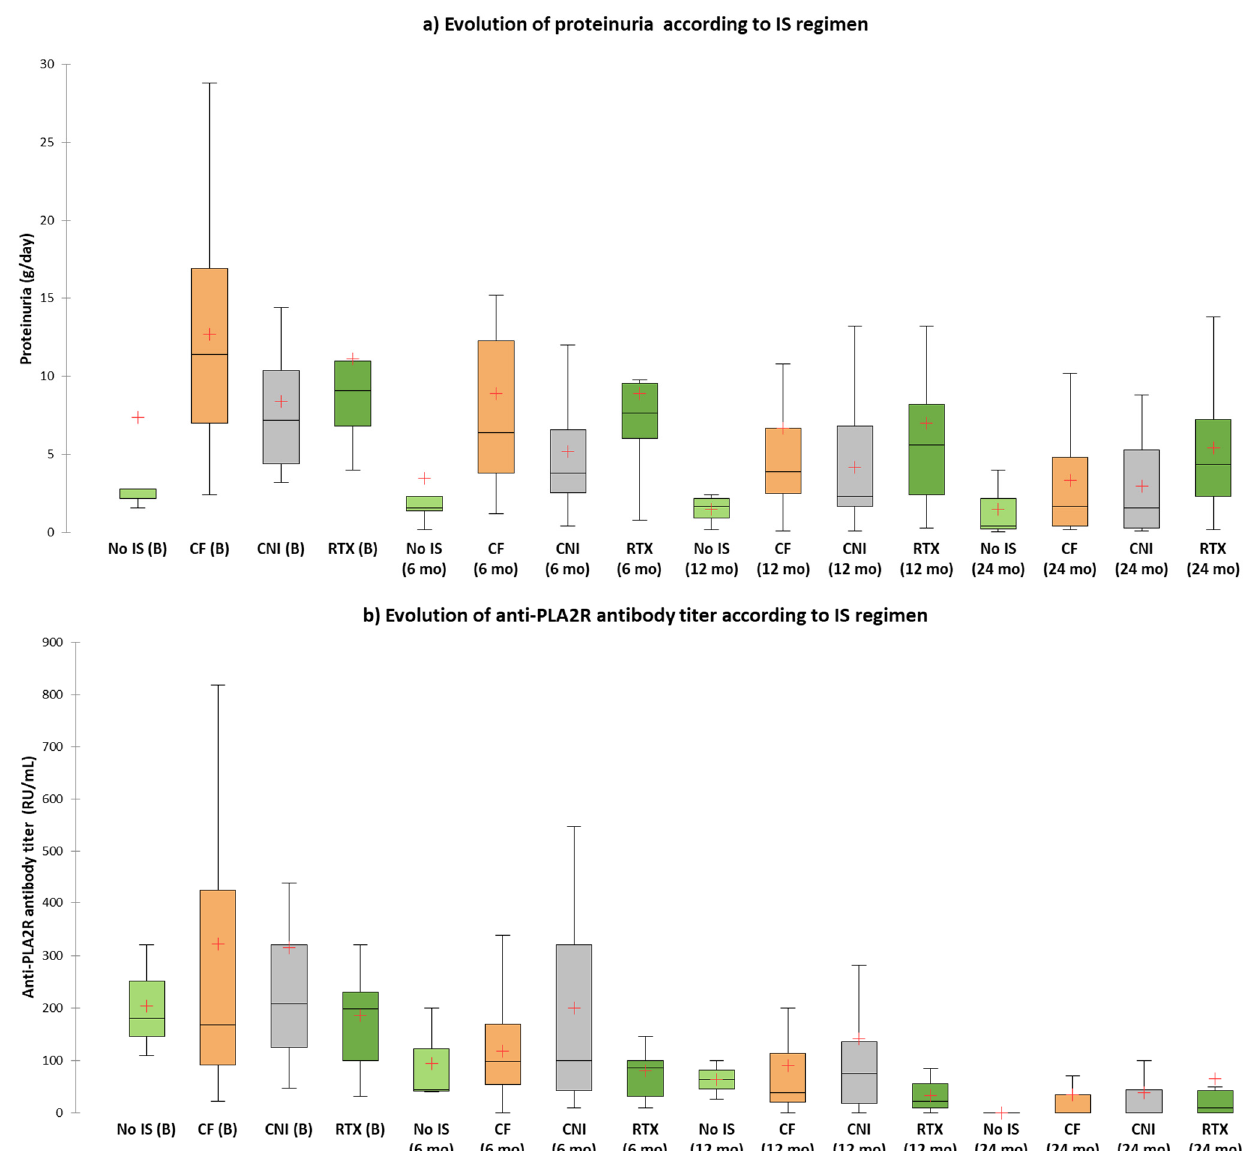
Figure 3. ( a ) Evolution of proteinuria according to IS regimen; ( b ) Evolution of anti-PLA2R antibody titer according to IS regimen.